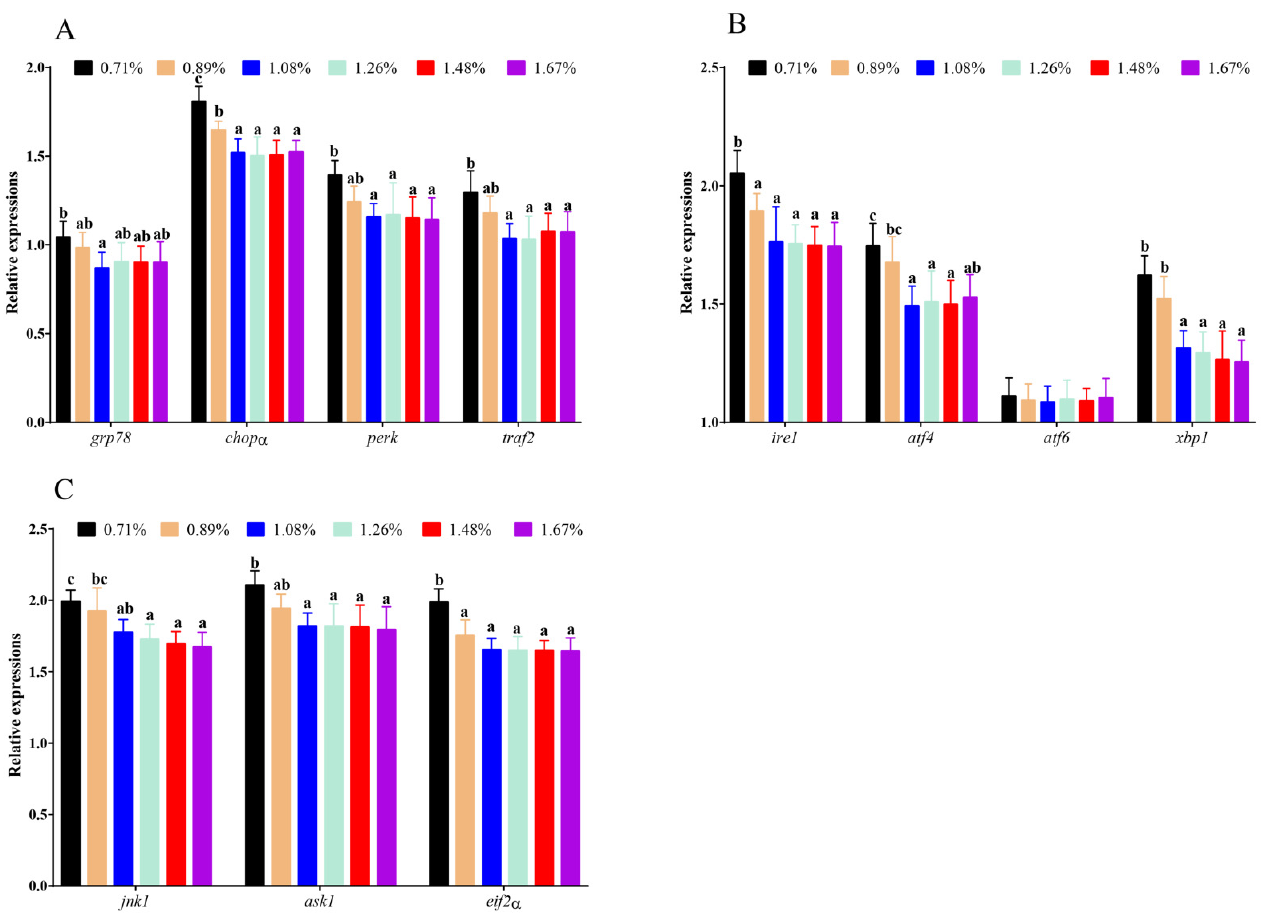
Figure 7. The mRNA levels of endoplasmic-reticulum-stress-related genes against graded different levels of dietary histidine. ( A ) showed the results of grp78 , chop α , perk and traf2 . ( B ) showed the results of ire1 , atf4 , atf6 and xbp1 . ( C ) showed the results of jnk1 , ask1 and eif2 α . Data are presented as mean ± standard deviation ( n = 3 × 3). Values with different alphabetical superscripts above bars are significantly different ( p < 0.05).